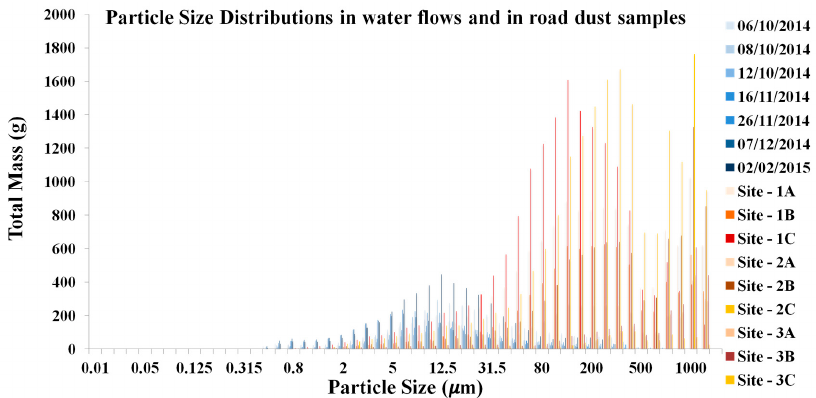
Figure 7. Particle Size Distributions of stormwater samples (blue bars) and road dust samples (yellow bars) during a dry weather sampling campaign (14 October 2014). Table 4. Two configurations of different particle size classifications.